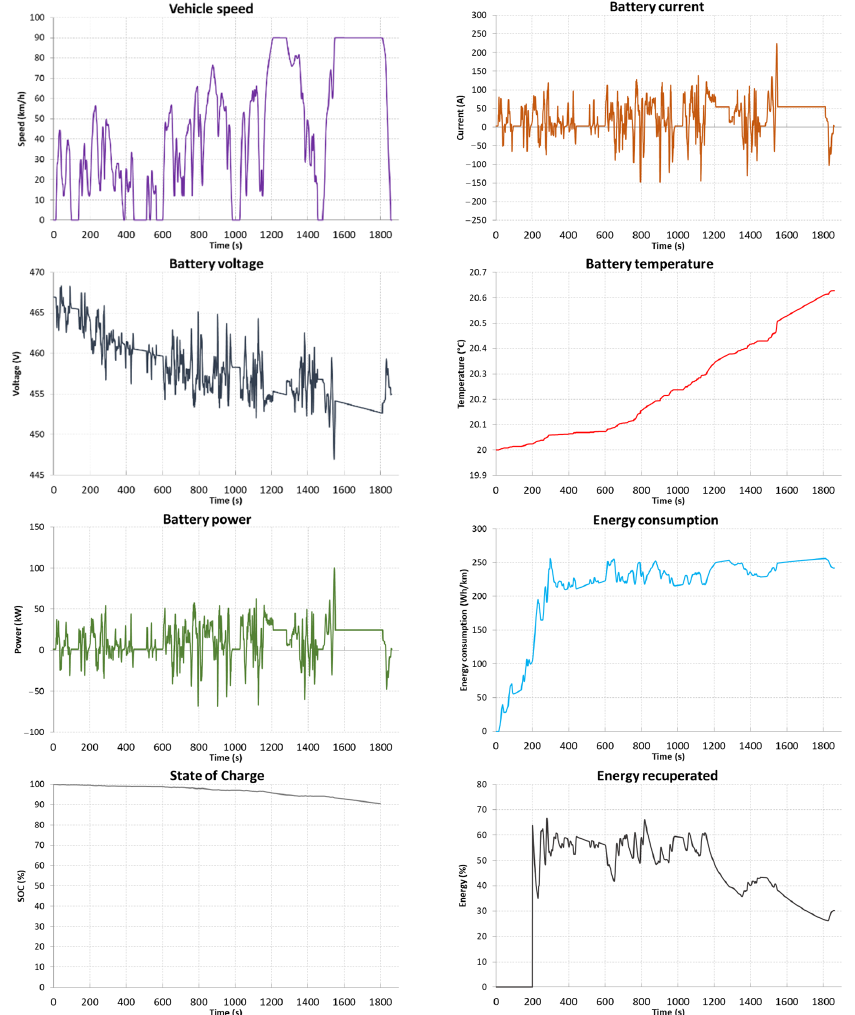
Figure 15. WLTP-90 results of simulation tests for the 4 × 4 drive system with Type 2 energy